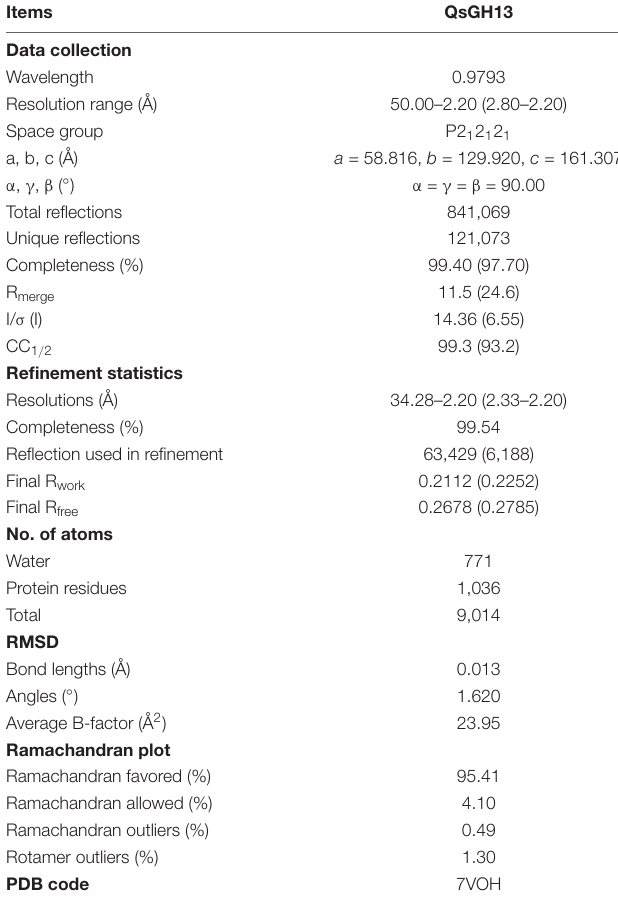
TABLE 1 | Data collection and refinement statistics of